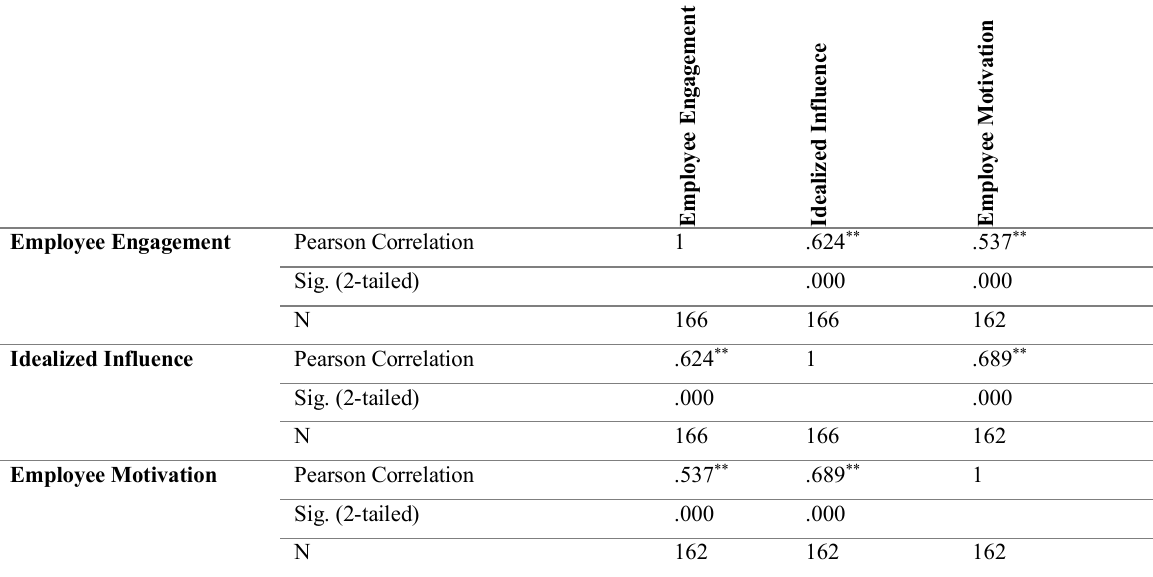
Table 3: Correlations between Employee Motivation, Idealized Influence and Employee